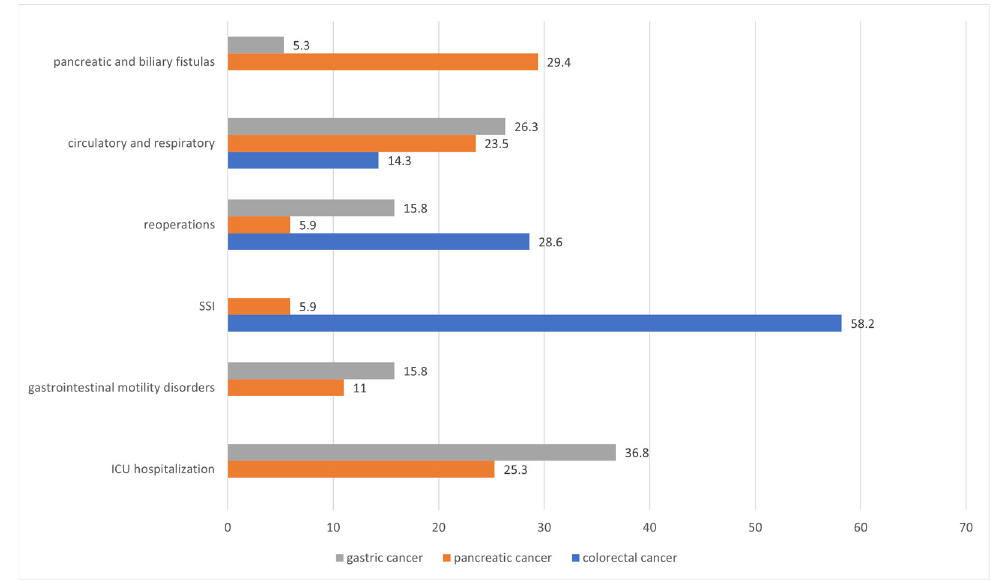
Figure 2. Types of postoperative complications depending on the location of the tumor.